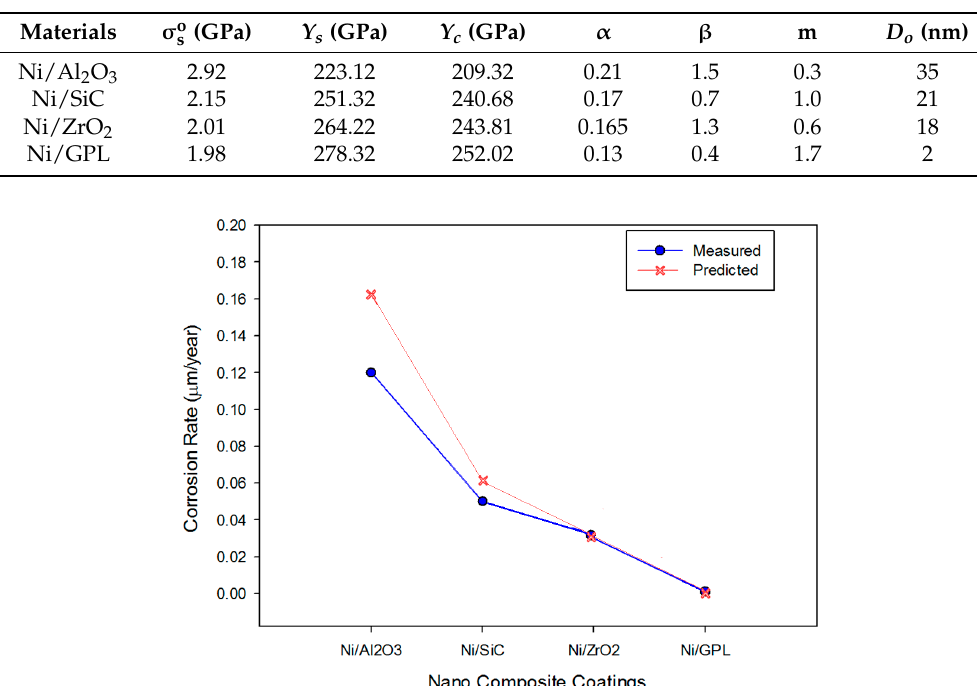
Figure 6. The predicted and measured corrosion rates. Table 2. Fitted parameter values from the MD simulations.